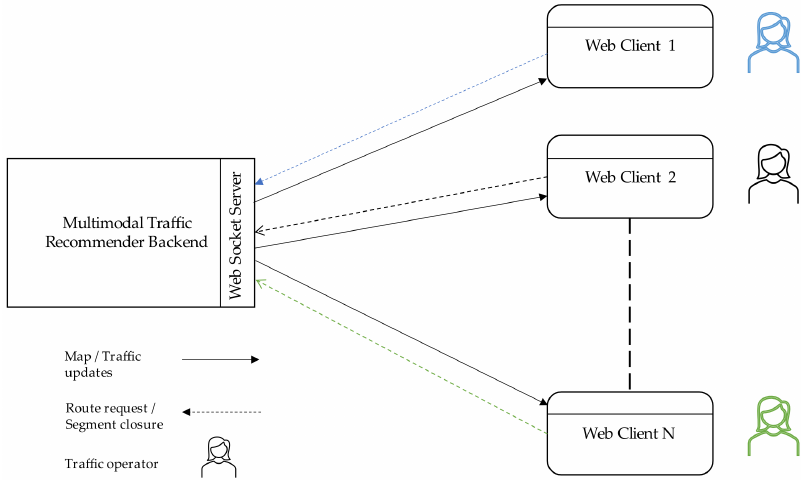
Figure 9. Multimodal recommender system to web clients